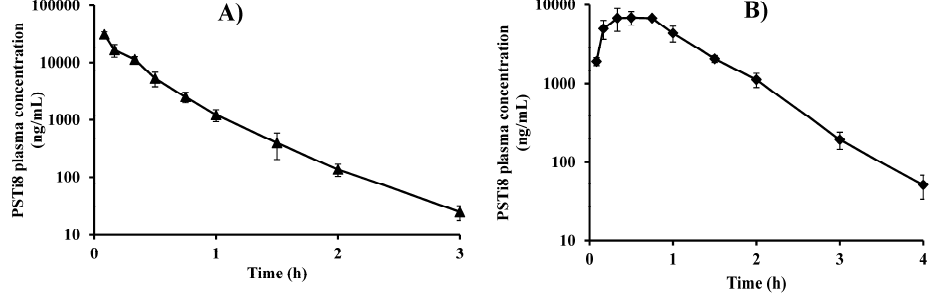
Figure 4. Pharmacokinetic studies of the PSTi8 peptide in female SD rats. Plasma concentration against time profiles of the PSTi8 peptide after at a dose of 5 mg/kg ( A ) i.v. and ( B ) i.p. administration to each group. Data are represented in n = 6 with the mean ± SD. Table 4. Pharmacokinetic parameters of the PSTi8 peptide after i.v. and i.p. administration at 5 mg/kg in female SD rats. Data are presented as the mean ± SD with n = 6.